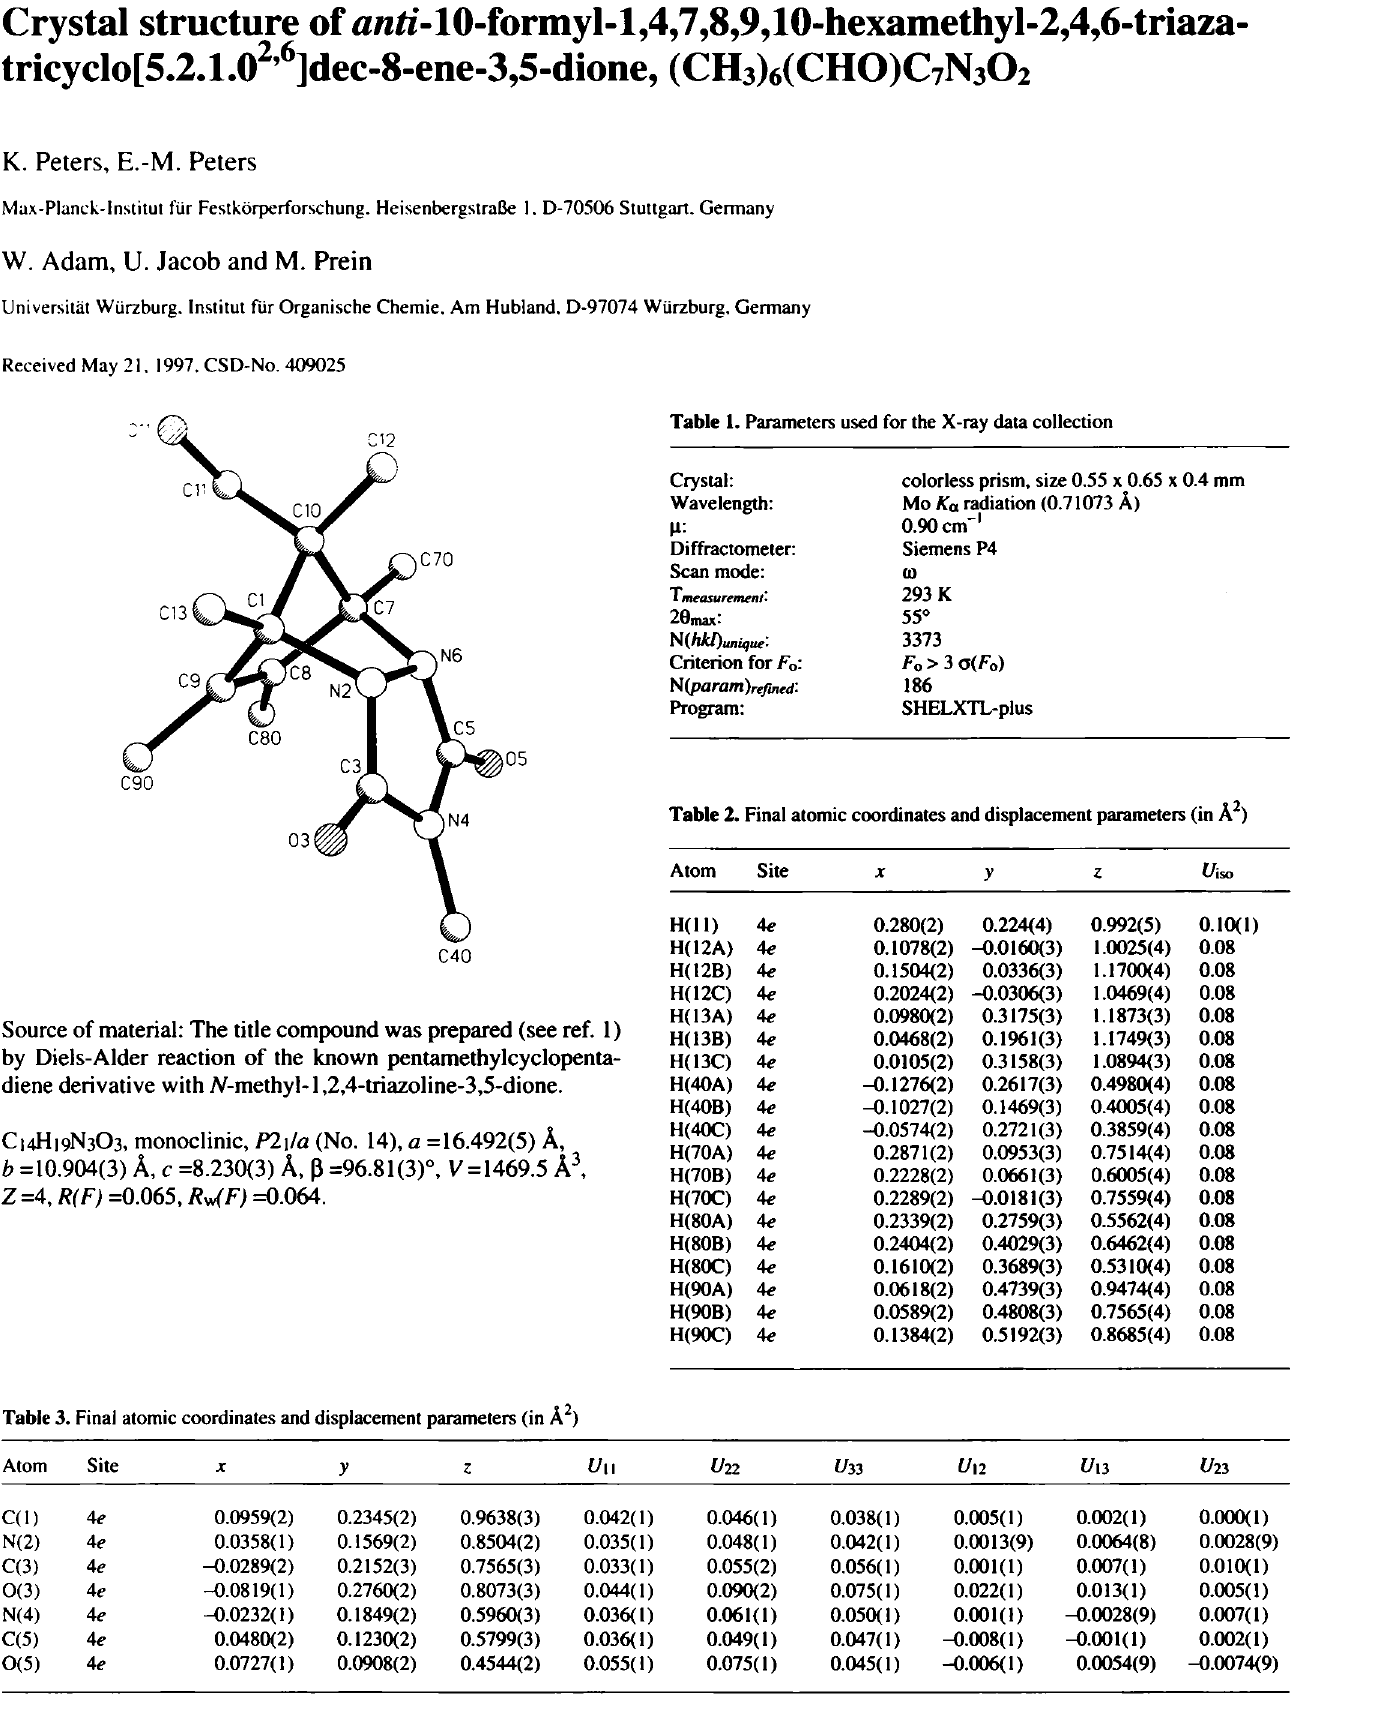
Table 1. Parameters used for the X-ray data collection